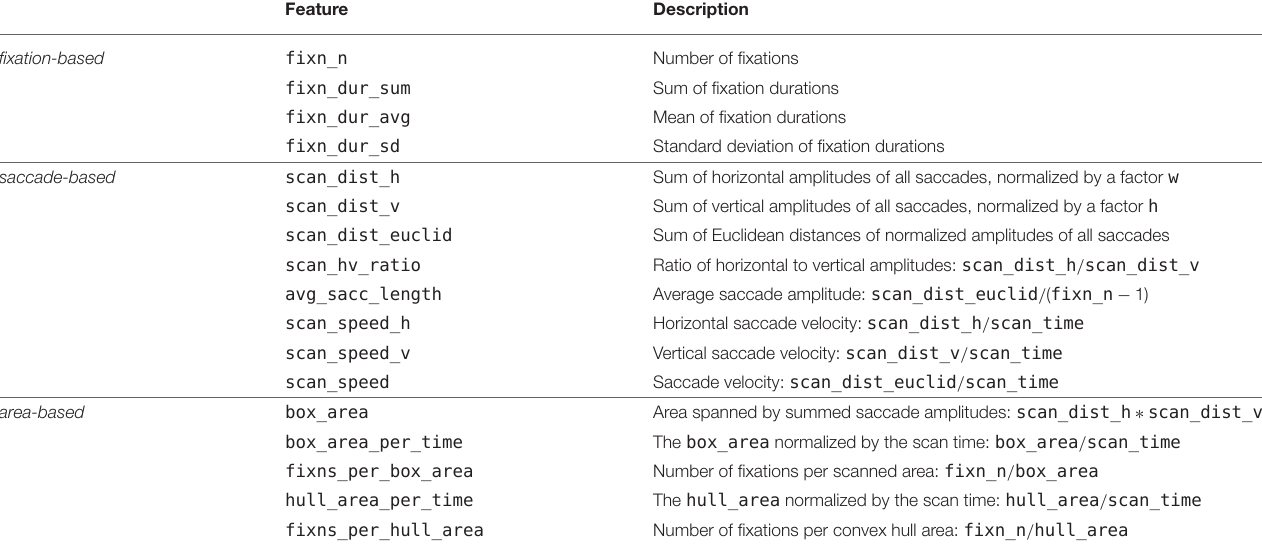
TABLE 1 | Overview of the 17 features adapted from Bhattacharya et al. (2020a) based on fixation events, saccadic eye movements, and the scanned area, which we use to encode paragraph visits.